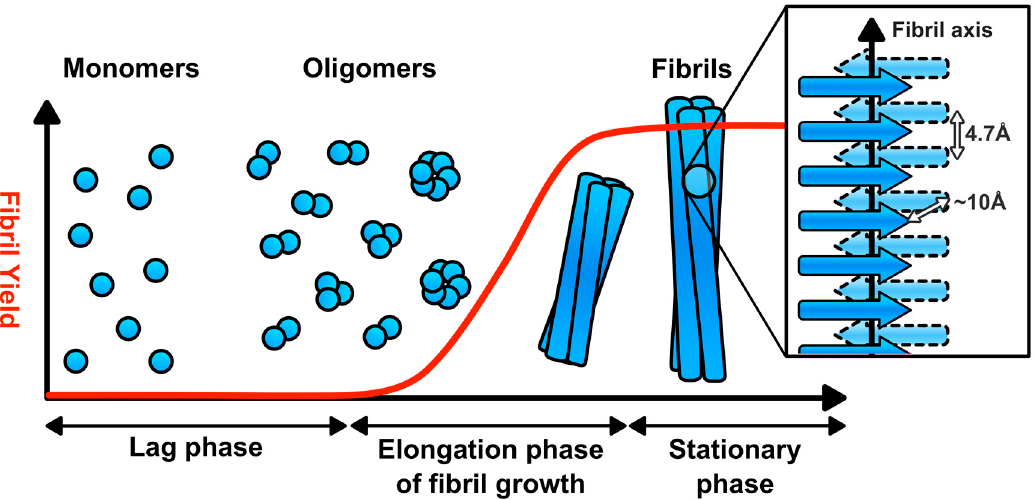
Figure 1. Amyloid fibril assembly. Amyloid fibril assembly is nucleation dependent. There is an initial lag phase, populated by prefibrillar oligomers, which ends with the production of the fibril nucleus. Fibrils then assemble in an exponential manner until the amyloidogenic precursor is exhausted. The resultant fibrils are composed of two or more protofilaments. Within each protofilament, the subunits have a cross- β core, corresponding to β -sheets aligned perpendicular to the long-axis of the fibril.